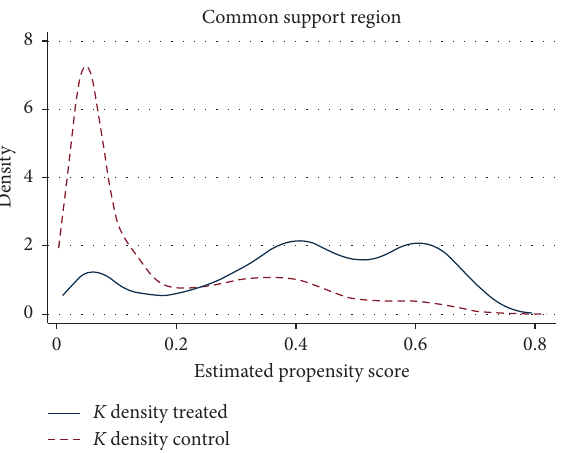
Figure 4: Density distribution of propensity scores for the treated and control groups. Table 4: Propensity score matching results: average treatment effect of grandparenting on the birth of the second child.